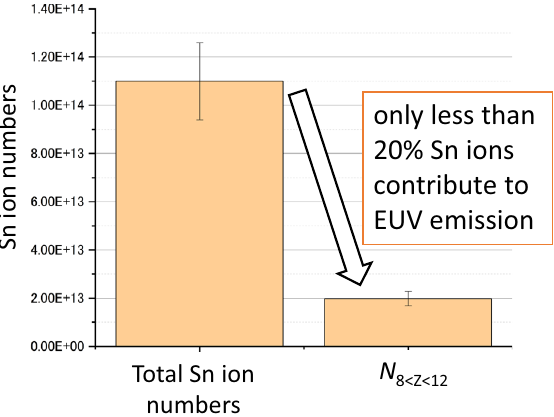
Figure 8. comparison of total Sn ion number and total N 8≤Z≤12 in the 700 µm diameter sphere for the case of the 2.0 µs plasma at t = 10 ns.